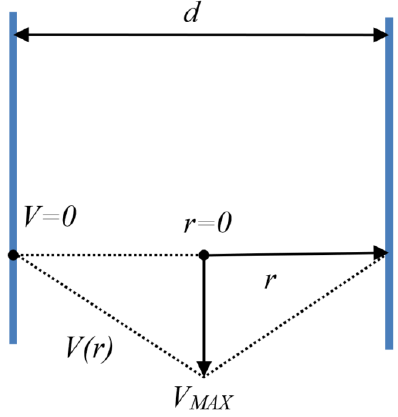
Figure 2. Model of ink velocity distribution inside the inkjet nozzle.